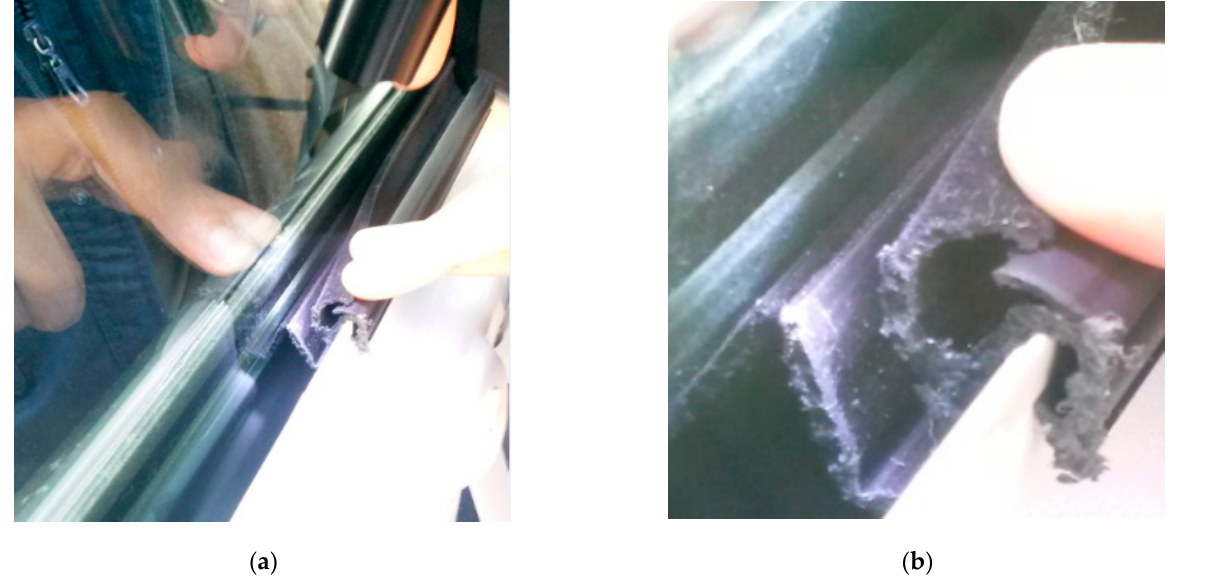
Figure 2. Schematic diagram of window and inner belt. ( a ) Schematic diagram of the window and inner belt; ( b ) physical picture of inner belt.